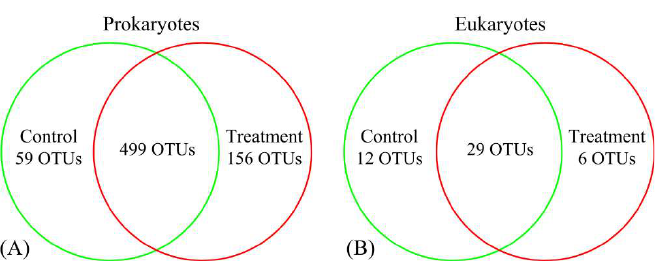
Table 2. Comparison of the α-diversity indices of larval microbial communities between control group and treatment group. Microbial Shannon Diversity Communities